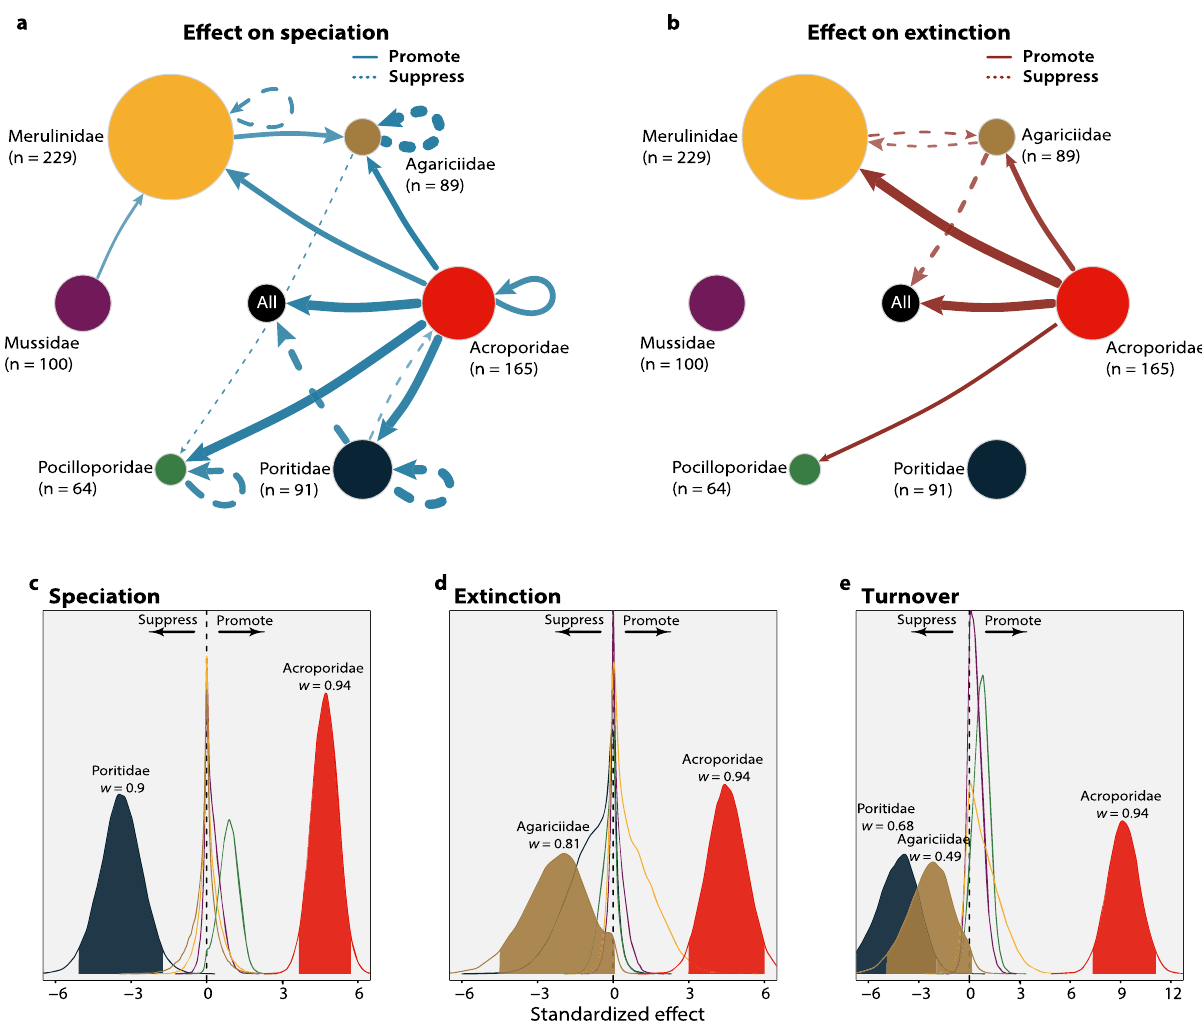
Fig. 3 The overwhelming cross-clade effect of Acroporidae on the diversity of reef corals. A network depicts the estimated cross-clade in fl uence on rates of speciation ( a ) and extinction ( b ). Arrows represent the directionality of interaction effects, while arrow widths are proportional to the estimated median effect. Continuous or dashed lines indicate promoting or suppressing effects, respectively. Only interactions with a strong signal in the model were included ( w > 0.7; see Methods). Loops represent self-diversity dependency; i.e., when confamilial species in fl uence their own diversity trajectories. The size of each external node is proportional to the number of fossil occurrences in each family, and the number of fossil species in each family is shown in parenthesis ( n ). The central node represents all families combined, for which we also show the posterior distribution of effects on speciation ( c ), extinction ( d ) and lineage turnover ( e ; effect on speciation plus effect on extinction). Filled densities represent effects estimated with a strong signal ( w > 0.7). The median shrinkage weights ( w ) are also shown for these families. Acroporidae — red; Agariciidae — brown; Merulinidae — yellow; Mussidae — purple; Pocilloporidae — green; Poritidae — dark blue. Source data are provided as a Source Data fi